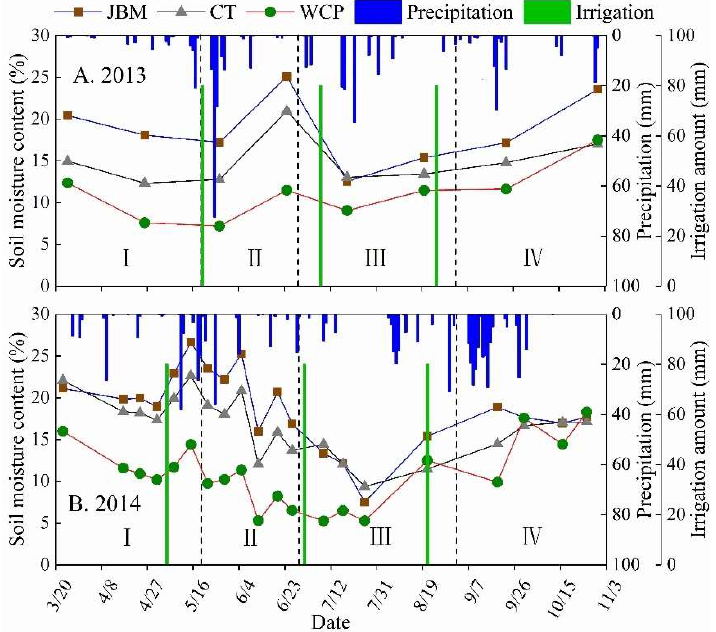
Figure 1. Changes in the 0–70 cm soil layer’s average soil moisture content under different mulching measures during the ( A ) 2013 and ( B ) 2014 jujube growth seasons. JBM: jujube branches were utilized as mulch throughout the entire jujube orchard; CT: clean tillage; and WCP: planting white clover throughout the entire jujube orchard. I: the budding and leaf-expanding stage, II: the flowering and fruit bearing stage, III: the fruit expansion stage, and IV: the fruit ripening stage (similarly hereinafter). Each data point was obtained using the procedure described below: First, average the seven soil moisture measurements of the monitoring point in the 0–70 cm soil layer to represent the soil moisture content of the monitoring point; then, average the soil moisture content of the three monitoring points in the left, center, and right locations to represent the soil moisture content of the soil box; and lastly, average the soil moisture content of the two soil boxes with the same mulching treatment to represent the soil moisture content of the mulching treatment. Due to prolonged periods of no precipitation during the experiment, the soil’s moisture content continued to decline, coming perilously close to wilting moisture. Several irrigations were required to ensure the healthy development of jujube plants and white clover.